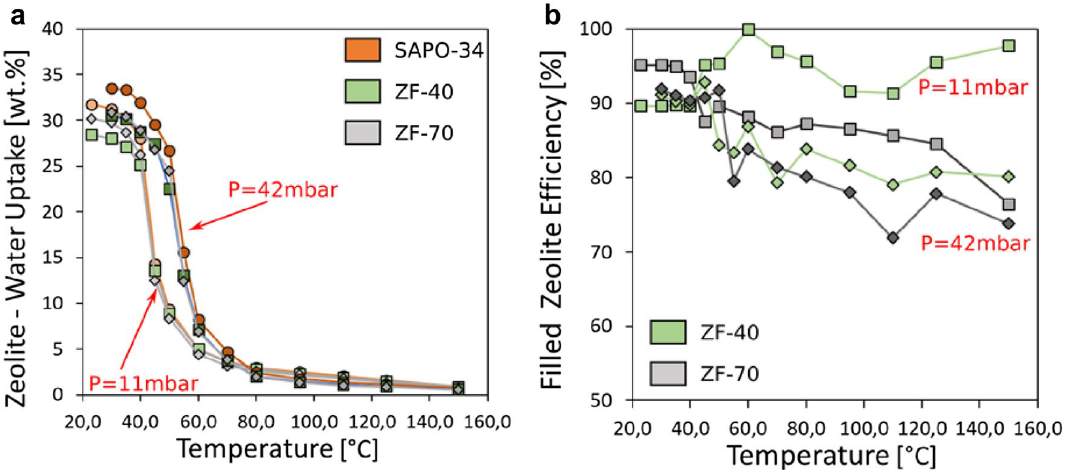
Fig. 10 Water adsorption isobars ( a ) and Filled zeolite efficiency ( b ) for filled zeolite foams (ZF-40 and ZF-70) and pure zeolite powder at P = 11 mbar and P = 42